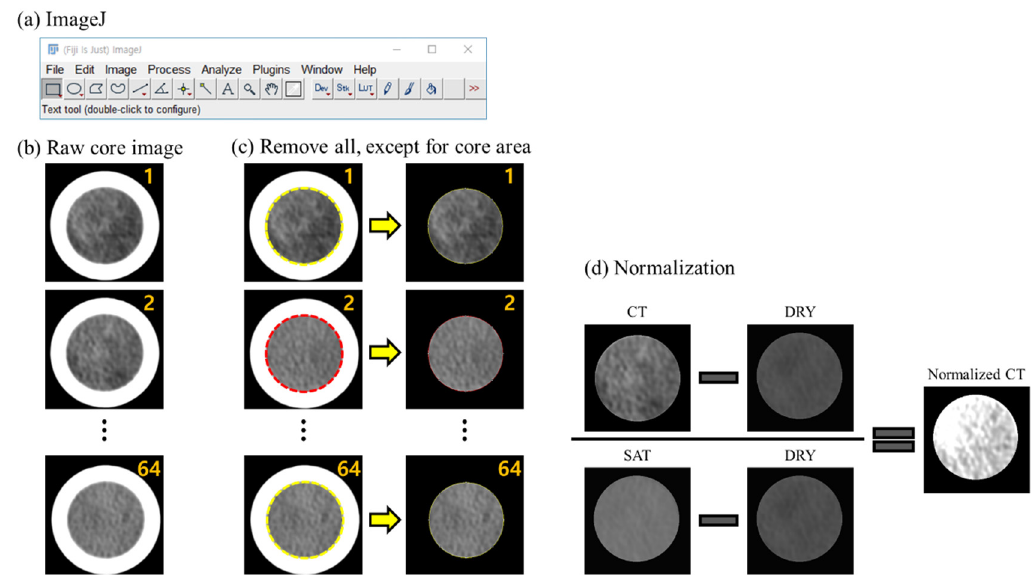
Figure 4. Modification and normalization of the CT images using ImageJ. ( a ) the window of ImageJ software; ( b ) scanned raw core images of one sample from GH experiments; ( c ) removal of useless part from raw images; ( d ) normalization of images with those of “DRY” and “SAT” stages.